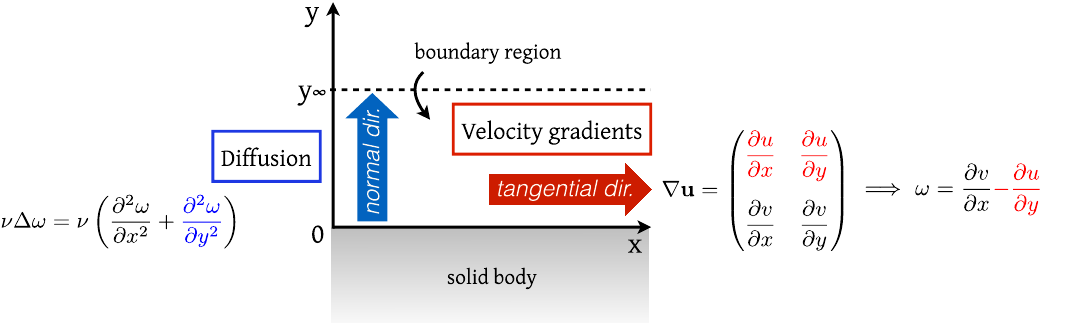
Figure 6. Graphical representation of the main directions driving the vorticity diffusion and the velocity gradients in the Prandtl